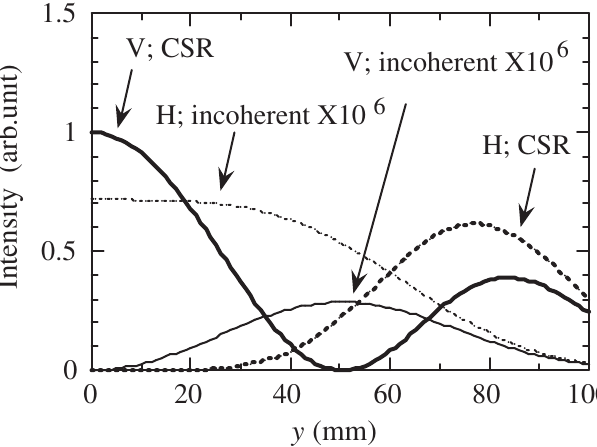
FIG. 4. Spatial intensity distribution along the y direction at ! (cid:7) 2 (cid:1) (cid:3) 0 : 68 THz . The same n ¼ 22 ( t ¼ 22 (cid:1)=! S ) for c normalization for the vertical axis as that for Fig. 3 is applied.